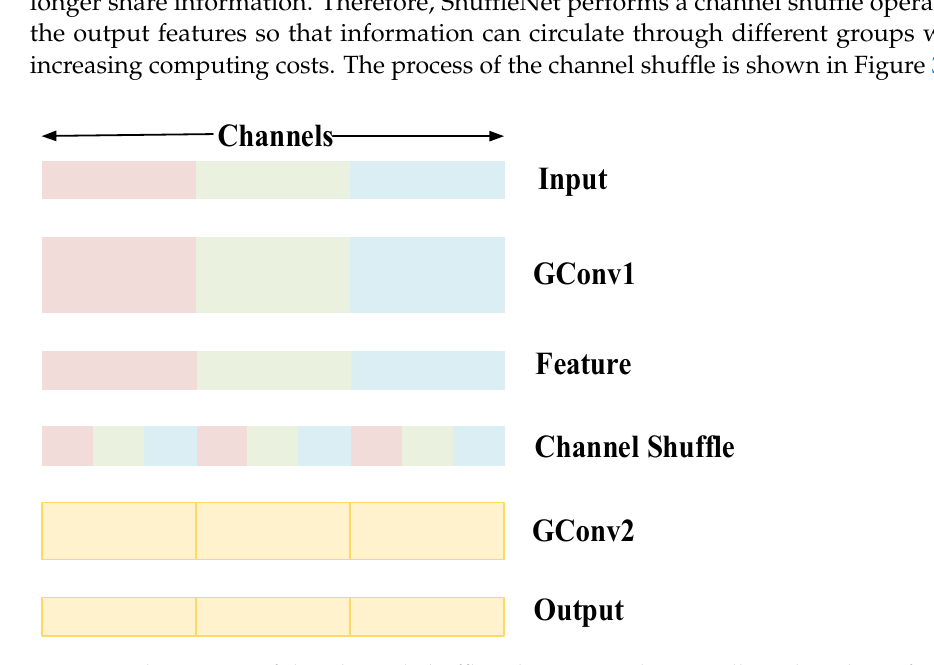
Figure 3. The process of the Channel Shuffle. The GConv2 layer is allowed to obtain features of different groups from the GConv1 layer due to the Channel Shuffle layer. That means the input and output channels will be fully related. (GConv: Group Convolution).